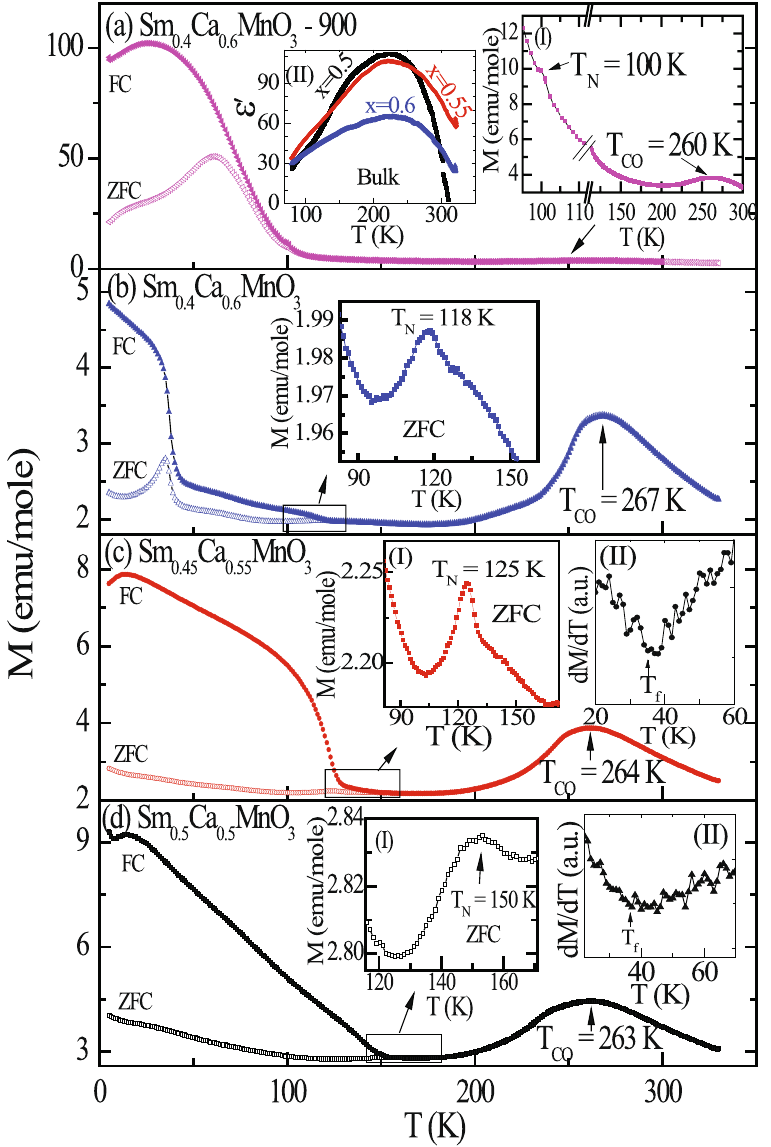
Figure 1. The temperature dependent magnetization of bulk Sm 1 − x Ca x MnO 3 (x = 0.5, 0.55 and 0.6) and Sm 0.4 Ca 0.6 MnO 3 -nano compounds at H = 100 Oe. Inset I of ( a ), shows the enlarged view of the magnetization M(T) to point out the charge ordering signature and AFM ordering present even in nanoparticle. Inset II of ( a ) shows the dielectric constant of bulk Sm 1 − x Ca x MnO 3 (x = 0.5, 0.55 and 0.6) compounds. Inset of ( b ) and insets I of ( a , c , d ) shows the enlarged view of the magnetization M(T) close to their respective AFM ordering temperatures. Insets II of ( c , d ) show the derivative curve of